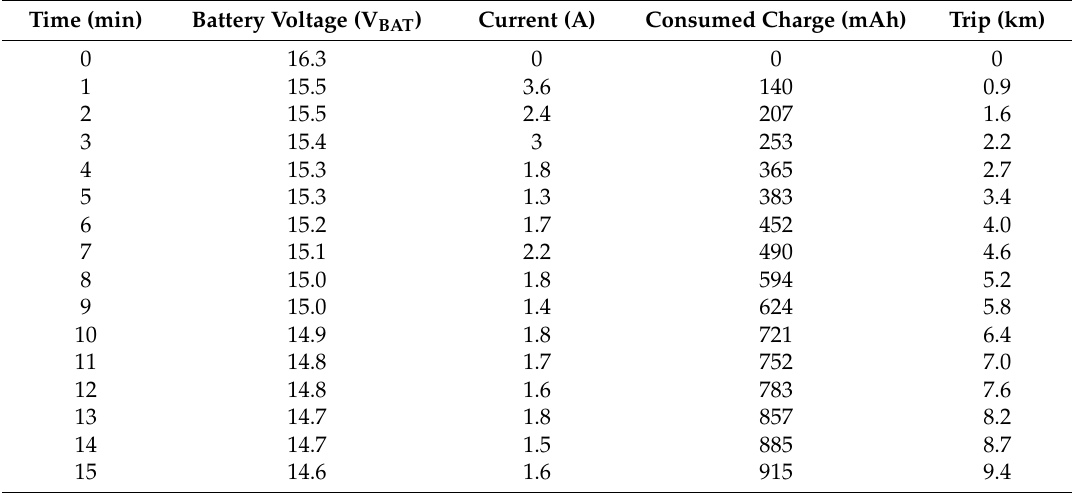
Table 2. Data collected for the test of the airplane model with a PV system (air density ρ = 1.174 kg/m 3 ). Time